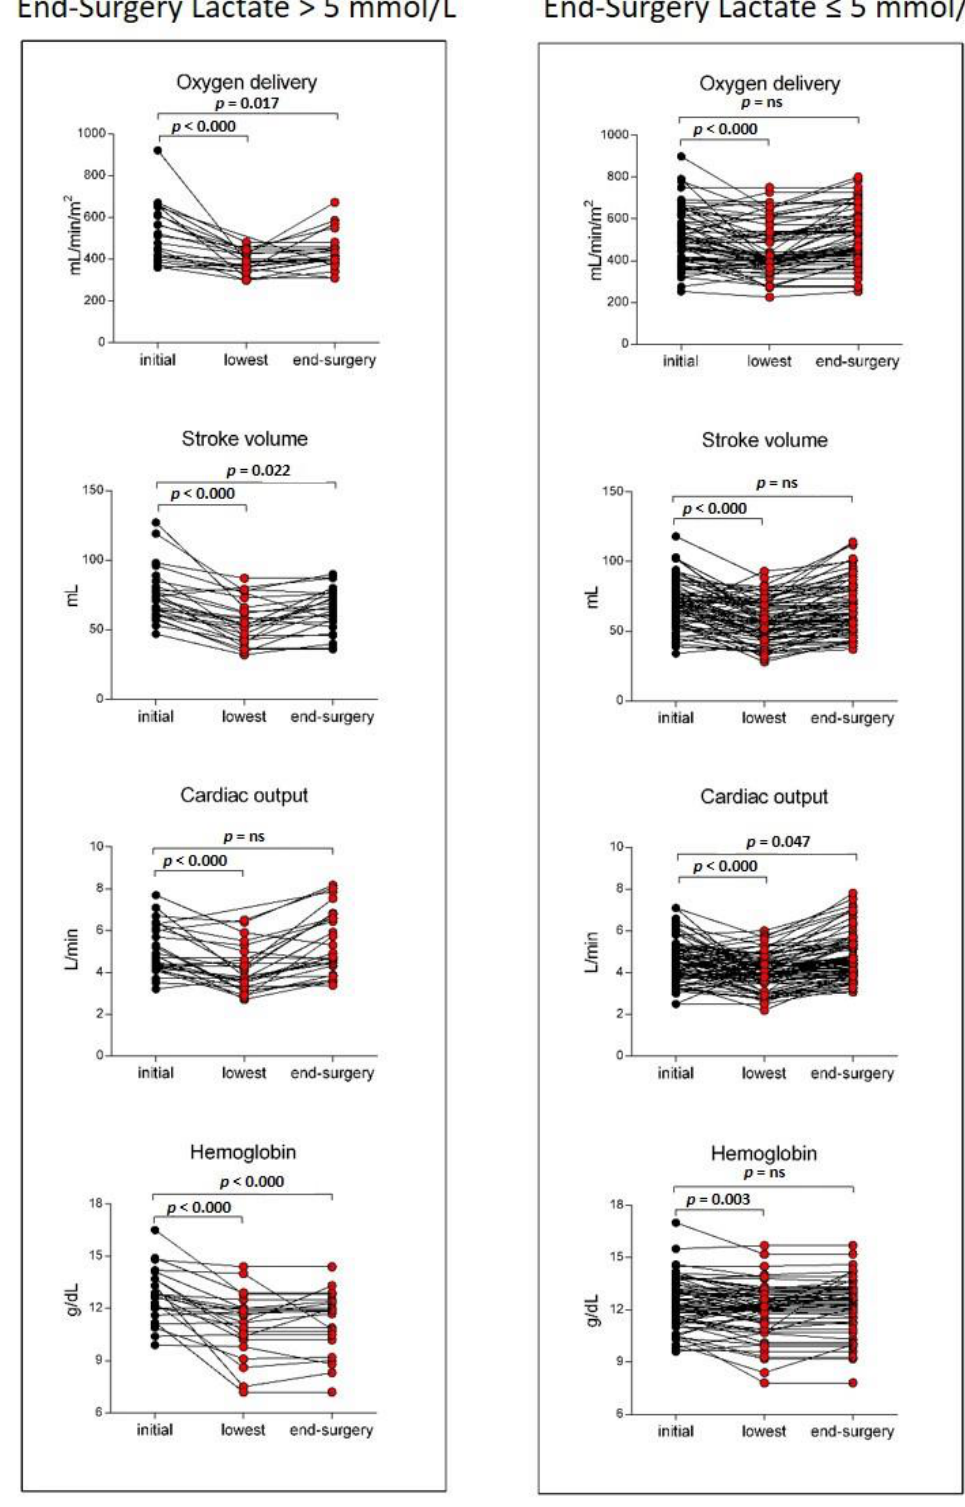
Figure 3. Paired analysis of initial, lowest, and end-surgery levels of oxygen delivery, stroke volume, cardiac output, and hemoglobin concentration in patients grouped according to end-surgery lactate level ( ≤ or >5 mmol/L). (ns, not